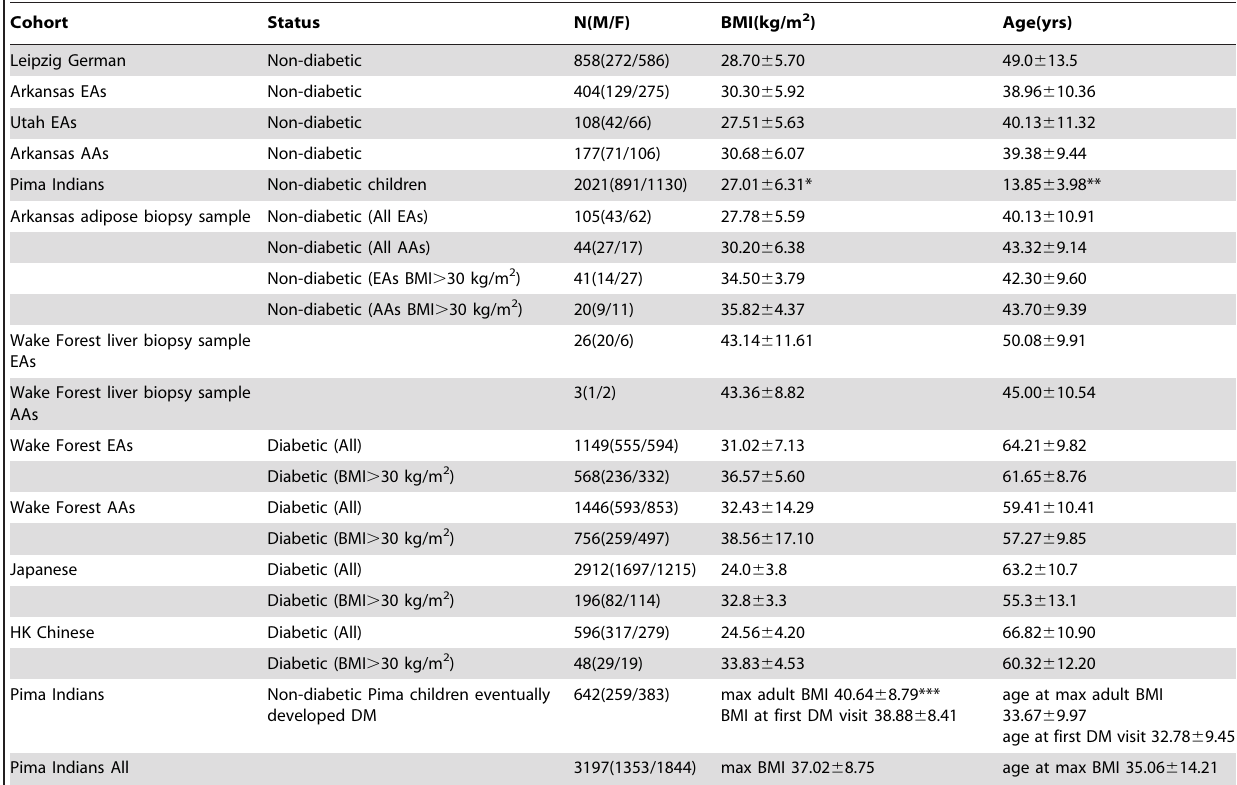
Table 1. Demographic data of the study